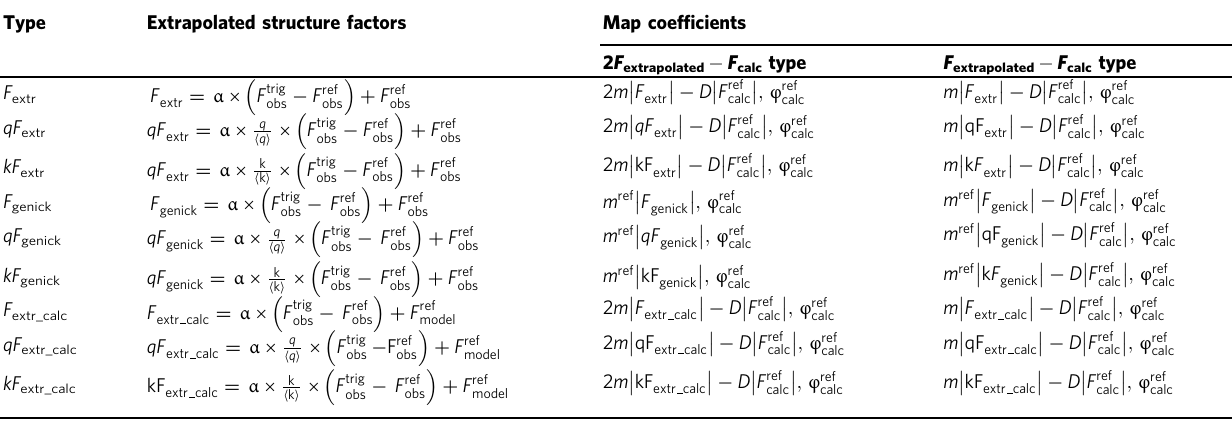
Table 1 Types of ESFAs calculated by Xtrapol8 and corresponding map coef fi cients. Type Extrapolated structure factors Map coef fi cients